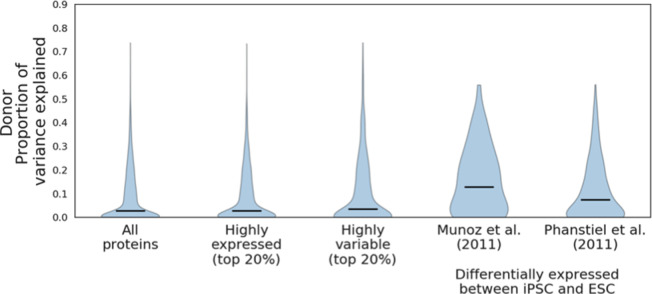
Donor variance components of proteins differentially expressed between iPSC and ESC.Donor variance component results for all proteins and subsets of highly expressed and highly variable proteins, compared to the donor variance components for proteins reported as differentially expressed between iPSC and Munoz et al., 2011 (a set of 81 proteins) and Phanstiel et al., 2011 (a set of 255 proteins) (see Materials and methods). Horizontal black bars denote median variance components.